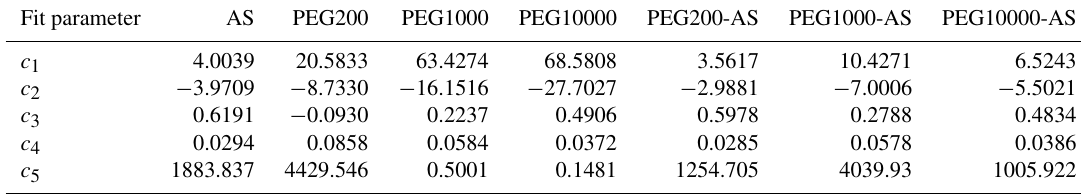
Table A1. Parameters describing the five-parameter sigmoidal curves fit to measurements of CCN activation fraction. Experimental CCN activation fraction data and the best-fit sigmoidal curves are shown in Fig. 2. Pearson r values exceeded 0.99 for all aerosol